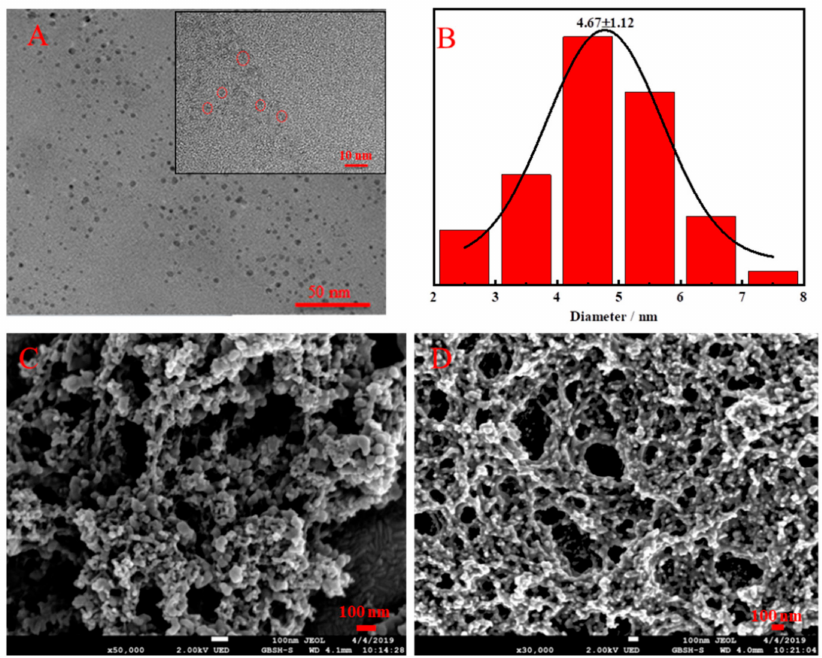
Figure 1. ( A ) A TEM image of the Cu NCs (inset shows an HR-TEM image of the Cu NCs) and ( B ) the diameter distribution of the Cu NCs. ( C , D ) are SEM images of Tb-GMP and Cu NCs@Tb-GMP,